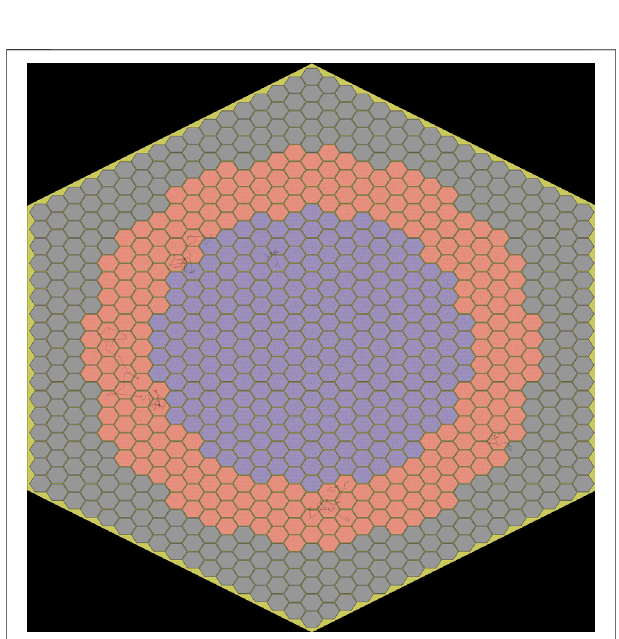
FIGURE 9 | The neutron transport tracks in a fast